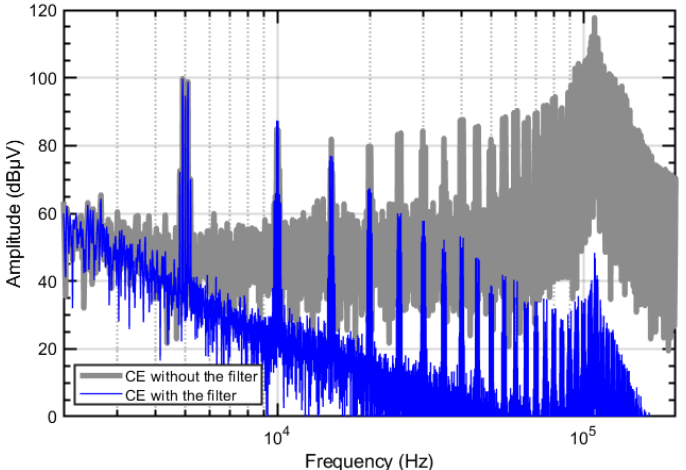
Figure 10. Conducted emissions at the AC side of the inverter in the presence and in the absence of the EMI filter.